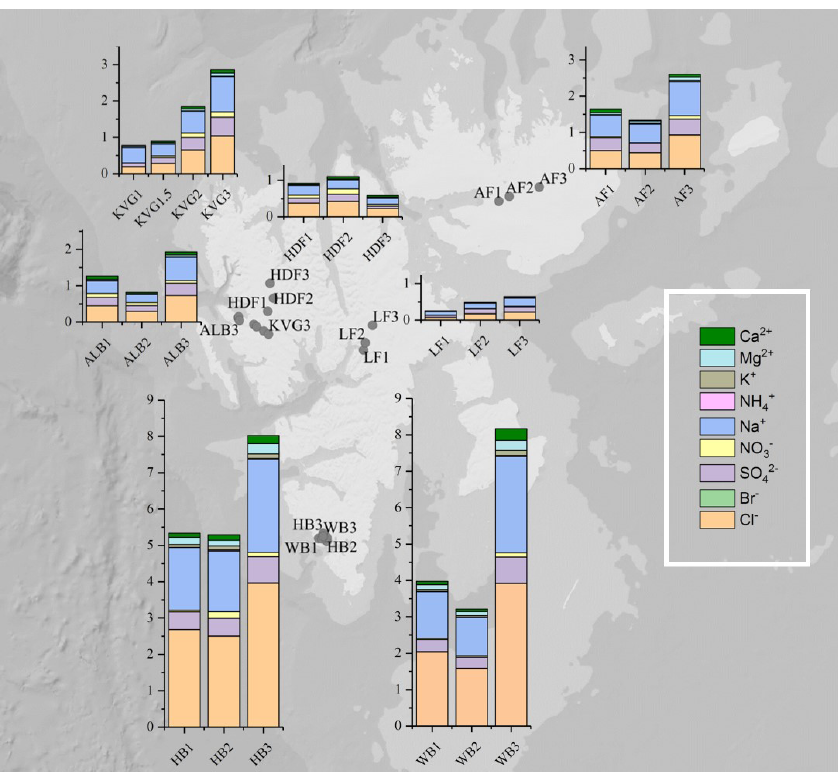
Figure 1. Total snowpack loads (mgm − 2 ) of major ions in 22 snowpits collected on glaciers during the C2S3 project. Seven glaciers were sampled in three snowpits in the lower ablation zone (1), near the equilibrium line (2), and in the upper accumulation zone (3), except on KVG glacier, where an extra snowpit was sampled within the ablation zone. Abbreviations: KVG = Kongsvegen, HDF = Holtedahlfonna, AF = Austfonna, ALB = Austre Lovénbreen, LF = Lomonosovfonna, HB = Hansbreen, WB =